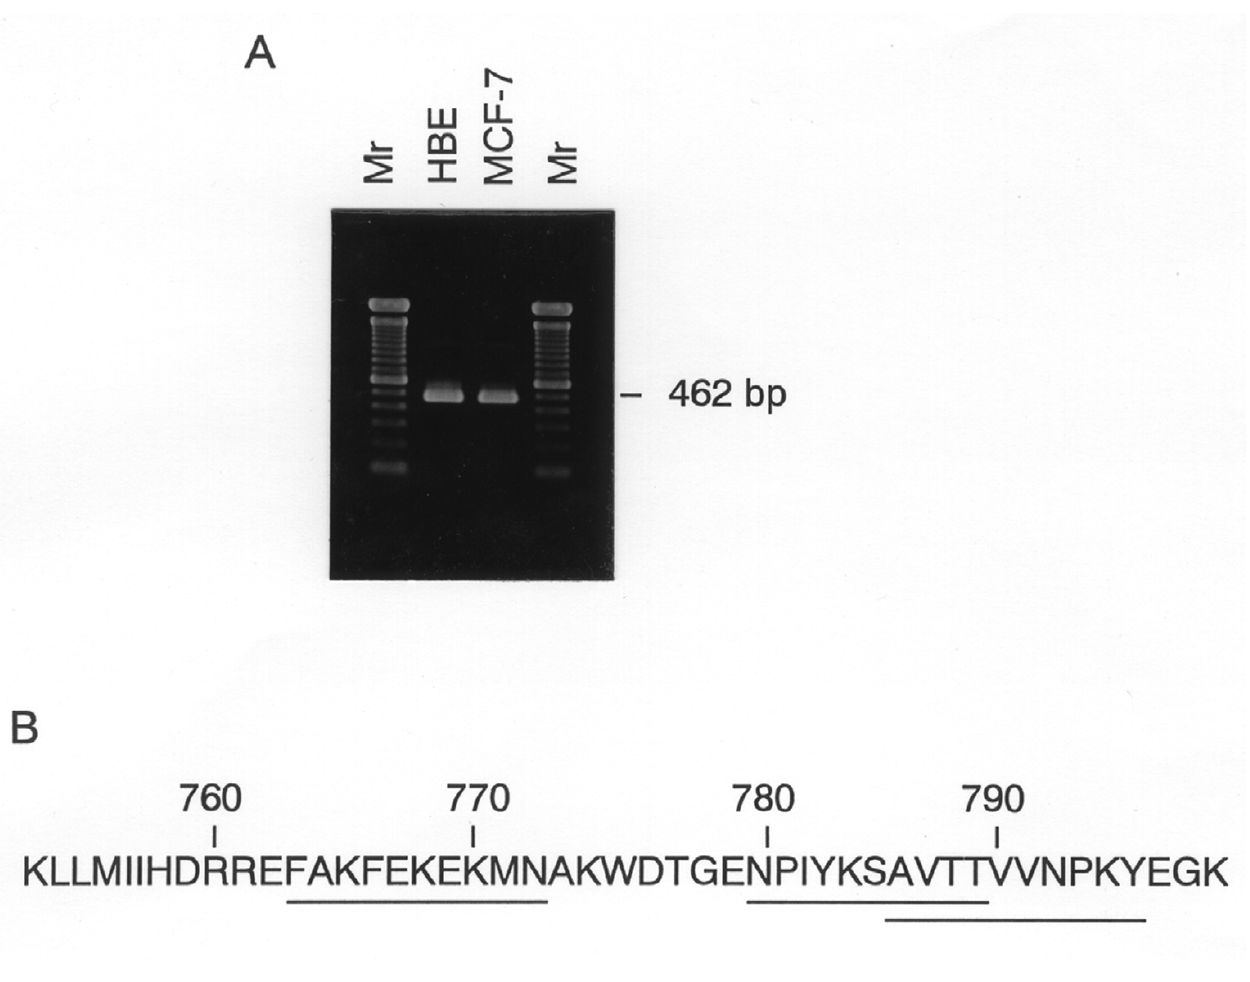
Figure 3 Amino acid sequence of the cytoplasmic domain of β 1 integrin in HBE or MCF-7 cells. (A) Agarose gel electro- phoresis of RT-PCR products. Total RNA was extracted from HBE or MCF-7 cells which were quiescent and adherent to col- lagen IV, and cDNA encoding the cytoplasmic domain of β 1 integrin was amplified by RT-PCR. The cDNA products were resolved in 1.6% (w/v) agarose gel electrophoresis with molecular size markers (Mr) and stained with etidium bromide. Molec- ular size of the cDNA products are indicated at right in bp. (B) The cDNA fragments of 462-bp were extracted from agarose gels and sequence analysis was carried out. Amino acid sequences of the three peptides with the highest affinity for α -actinin are underlined (adapted from